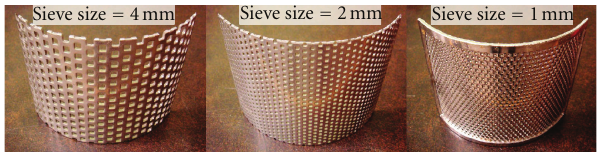
Figure 6: Sieves used in knife